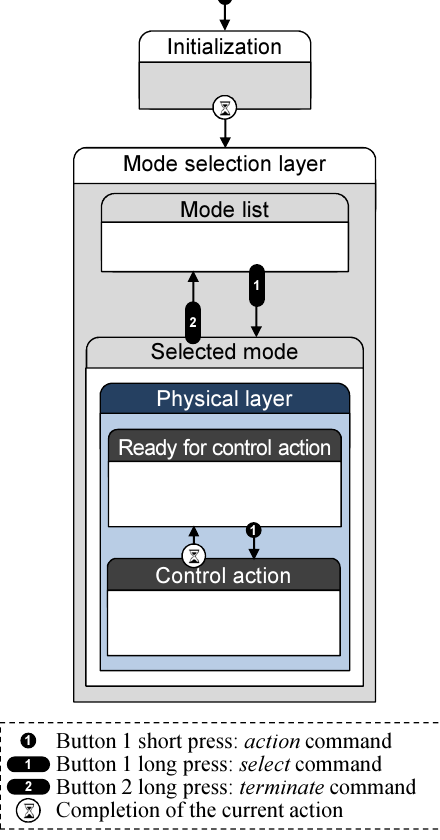
Figure 6. Operation strategy of the WalkON Suit using two tact